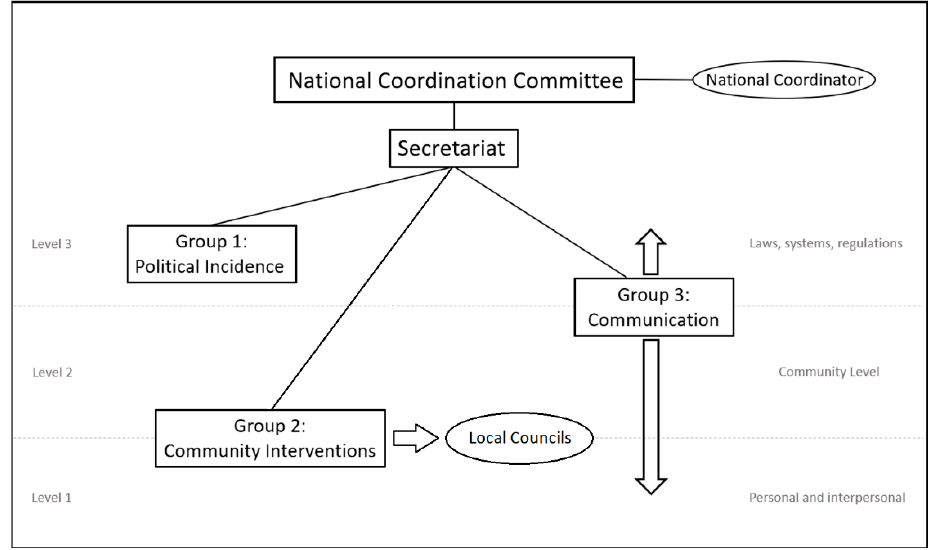
Figure 1. Organizational and operative structure of the collaborative platform. National Coordination Committee manages three working groups. Each group works at a different intervention level. Some groups can work at more than one